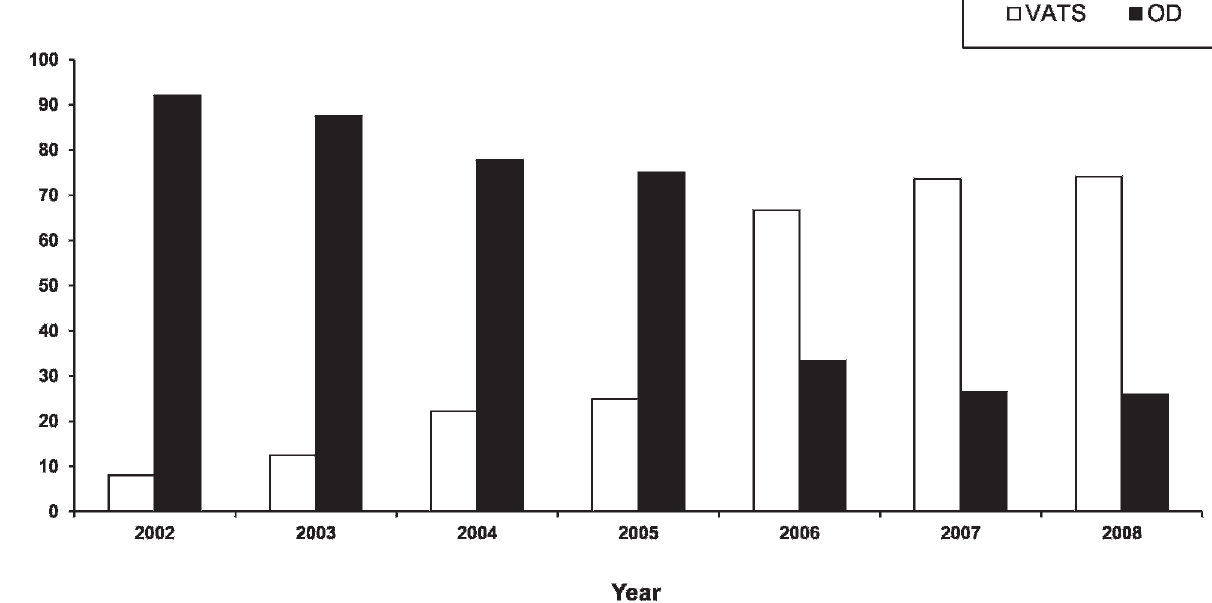
Figure 2 - Use of video-assisted thoracoscopic surgery (VATS) and open decortication (OD) for cases of pleural empyema according to year of the study. Each bar represents the relative percentage of cases performed using the VATS approach (white bar) or the open approach (black bar). It is noteworthy that the number of VATS cases performed tended to increase over time, whereas those using OD demonstrated a steady